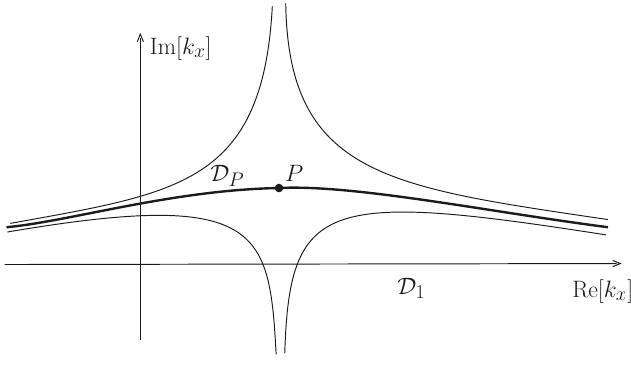
Figure 9 . Domain